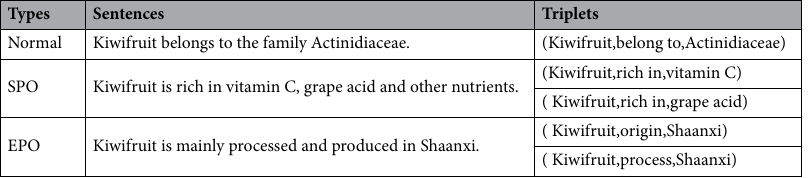
Table 1. Examples of the Normal, SingleEntityOverlap (SEO), and EntityPairOverlap (EPO) cases. The overlapping entities are marked in